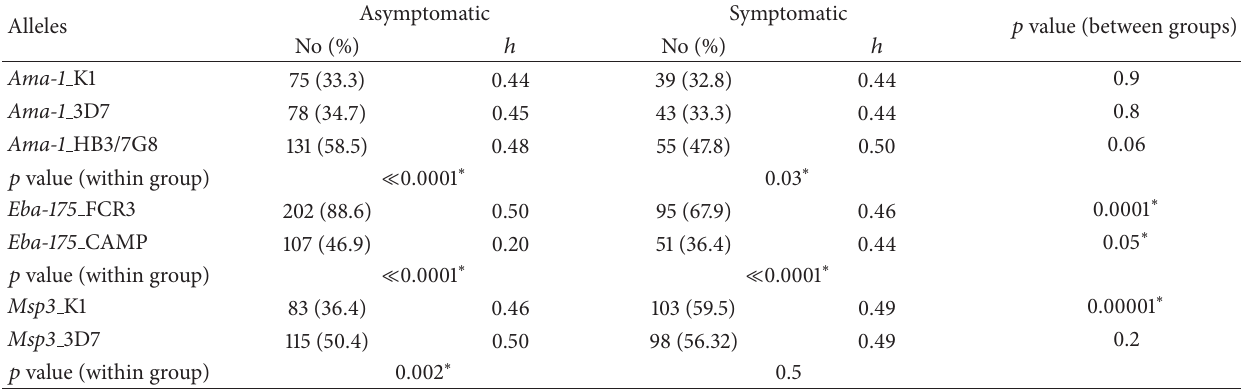
Table 2: Prevalence of ama-1 , eba-175 , and msp-3 genotypes from symptomatic and asymptomatic malaria cases. Asymptomatic Alleles